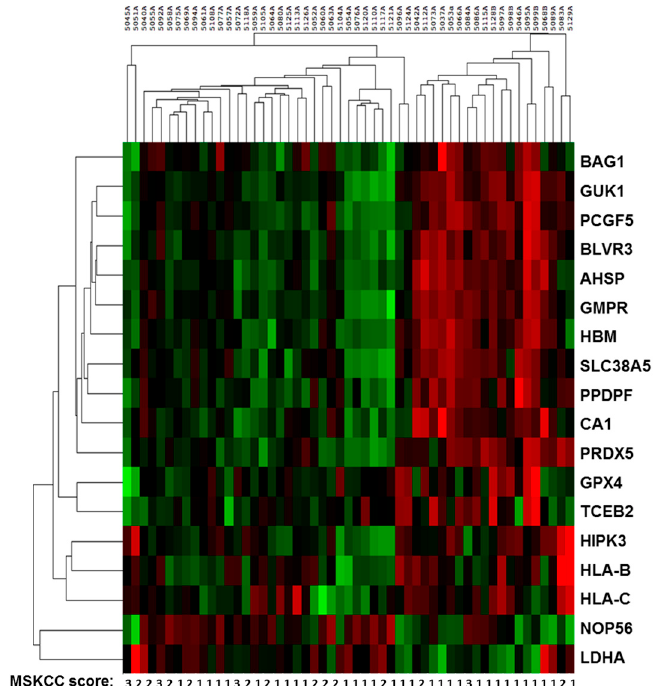
Figure 1. Heatmap of 18 targeted RNA transcript levels in the 47 patients from the validation set. Red indicates upregulation and green indicates downregulation. Labeled below is the MSKCC prognostic score for each patient.